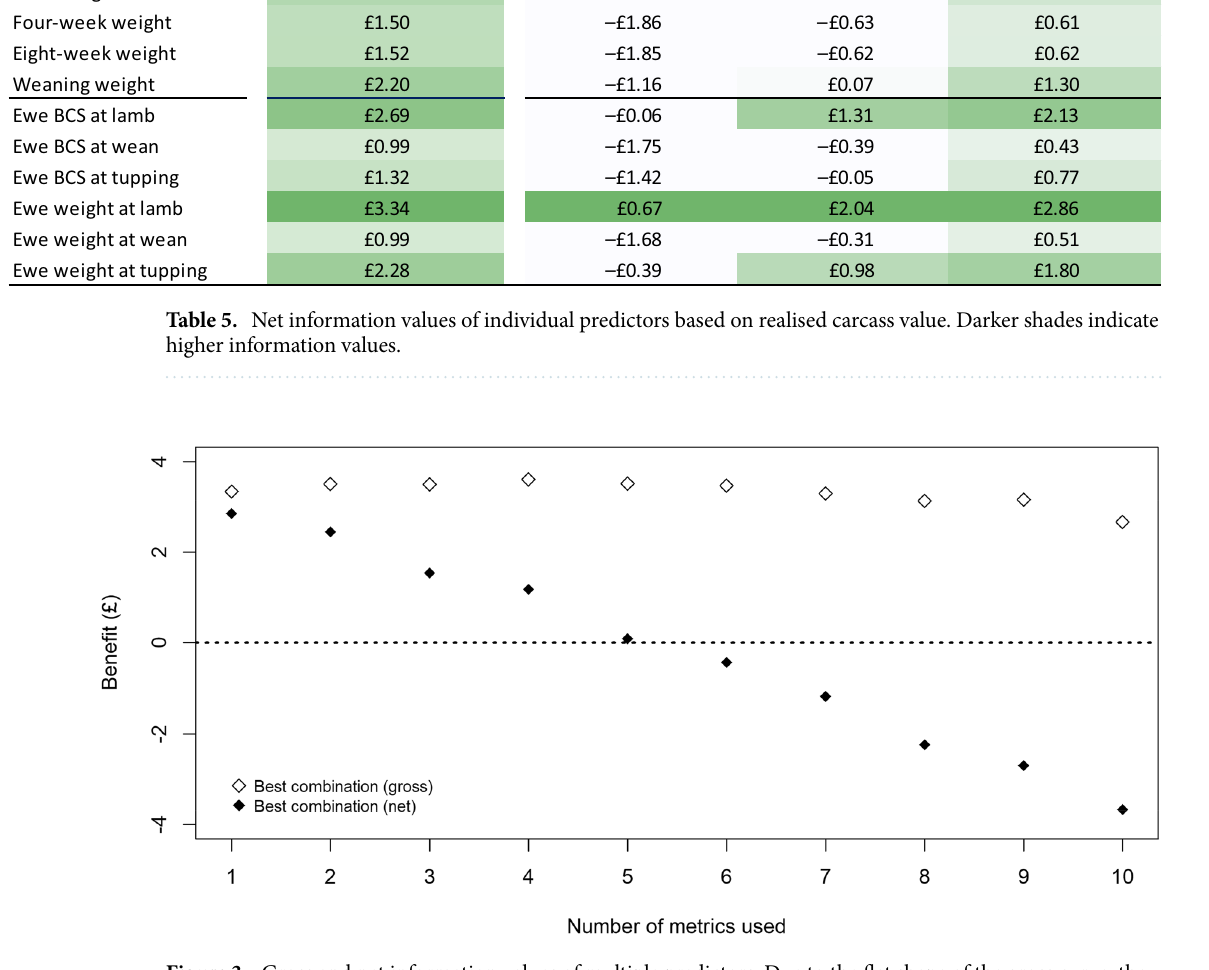
Figure 3. Gross and net information values of multiple predictors. Due to the flat shape of the gross curve, the net value linearly decreases as additional measurement costs are